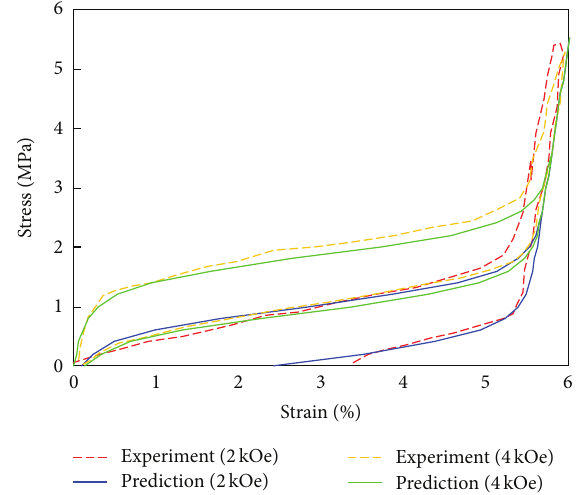
Figure 3: Effect of magnetic field on the stress-strain behavior of magnetic shape memory alloy in martensite, which is partially pseudoelastic at 2kOe and pseudoelastic at 4 kOe.